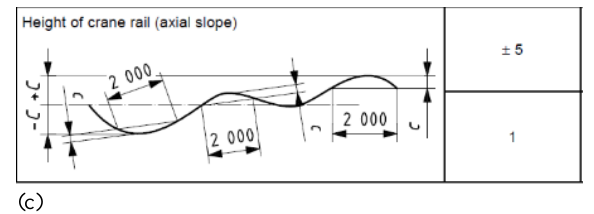
Figure 2. Construction tolerances for travelling tracks of class 1